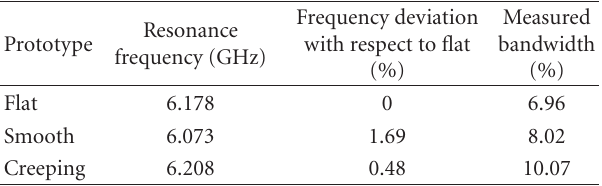
Table 2: Prototypes